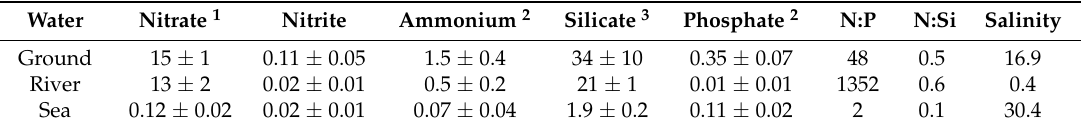
Table 1. Nutrient concentrations ( µ M) and standard error in groundwater, river water, and sea water used in the experiment, with significance denoted (ANOVA, Tukey-Kramer p < 0.05). N:P and N:Si were calculated from the other data. Standard error was derived from replicate samples.